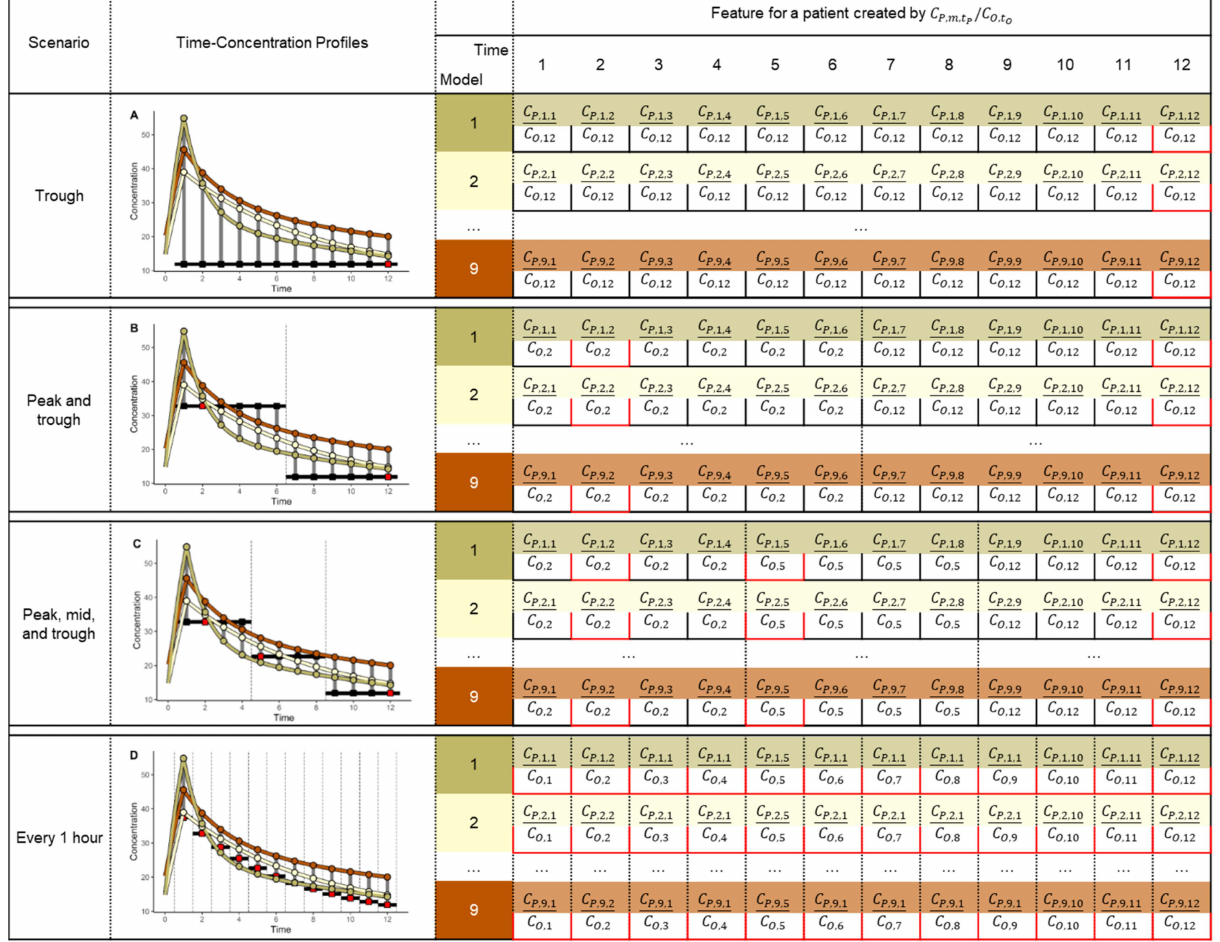
Figure 2. An illustrative example of feature creation. The yellow, olive, and brown lines are the time-concentration profiles of the population predicted concentration (C PRED ) using the three models. The round dots represent the C PRED of each PK model every hour for 12 h. The red squares represent the observed concentration (C OBS ) at each blood sampling time. The black squares represent the imputed C OBS at the unobserved time from the observed time. C P , m , t represent the C PRED for a P patient, where m is the number for the m th PK model of a total of nine PK models and t P is the time every hour from 1 to 12 h. C O , t represents the C OBS for a patient, where t O is the concentration O